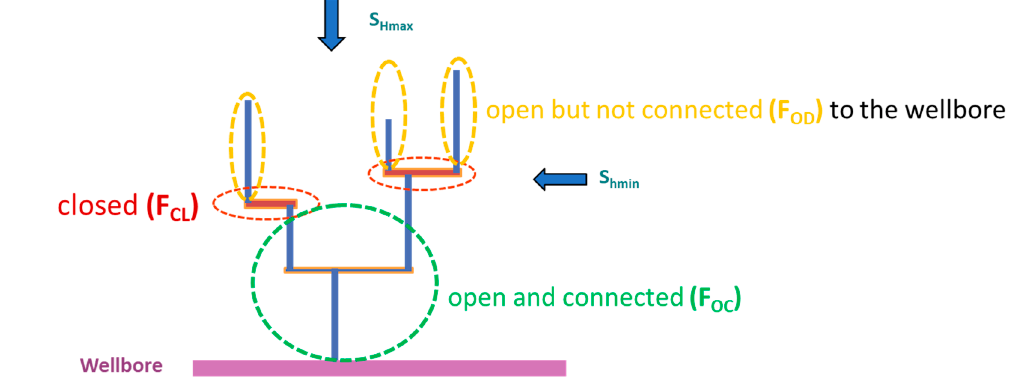
Figure 19. Fractures in a complex fracture network categorized based on the connectivity of a fracture to the wellbore.